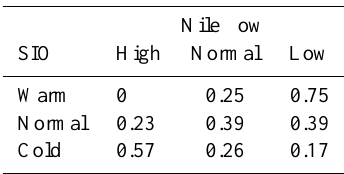
Table 3. Conditional probability of the Nile flow given SIO condi-